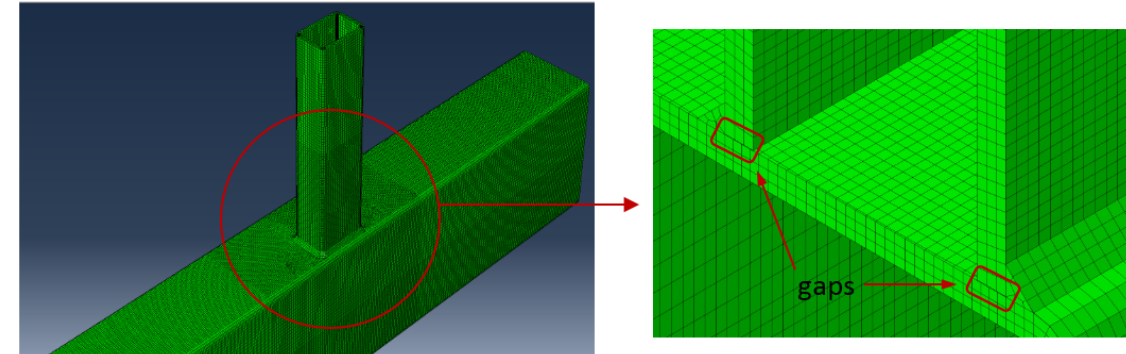
Figure 2. Finite element mesh of